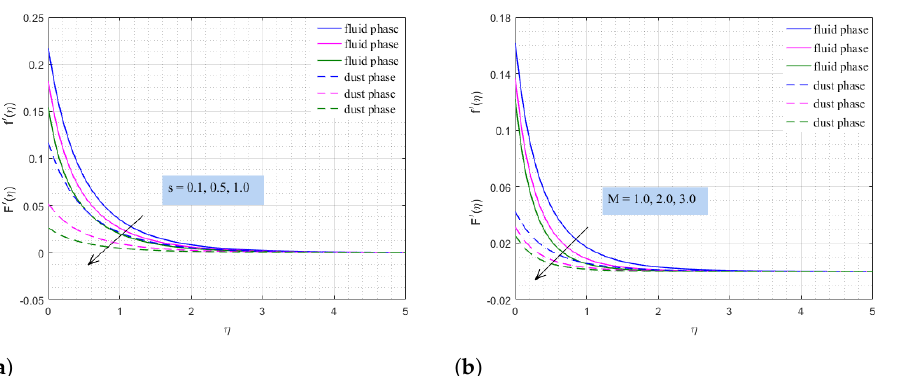
Figure 4. Change in the velocity profile at different values of certain parameters. ( a ) Change in velocity profile at different values of s. ( b ) Change in velocity profile at different values of